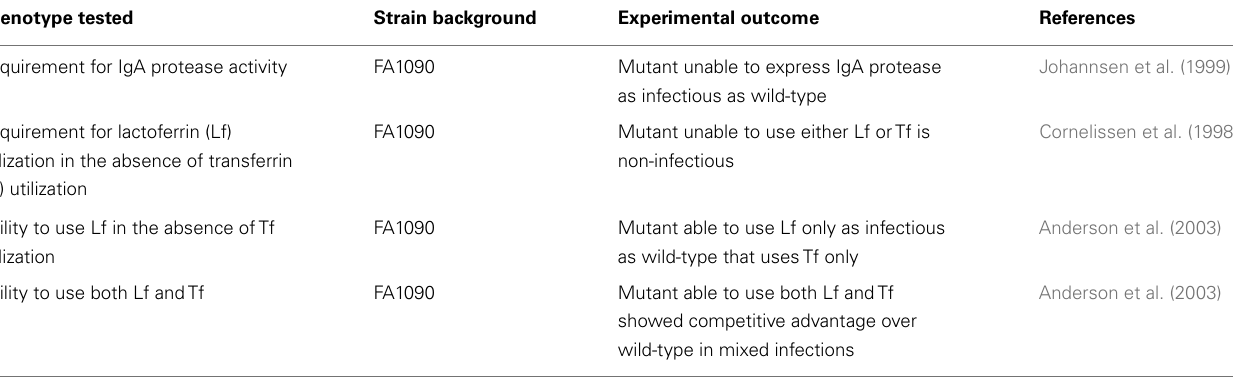
Table 4 | Requirements for IgA protease and iron acquisition from human iron-binding proteins during experimental